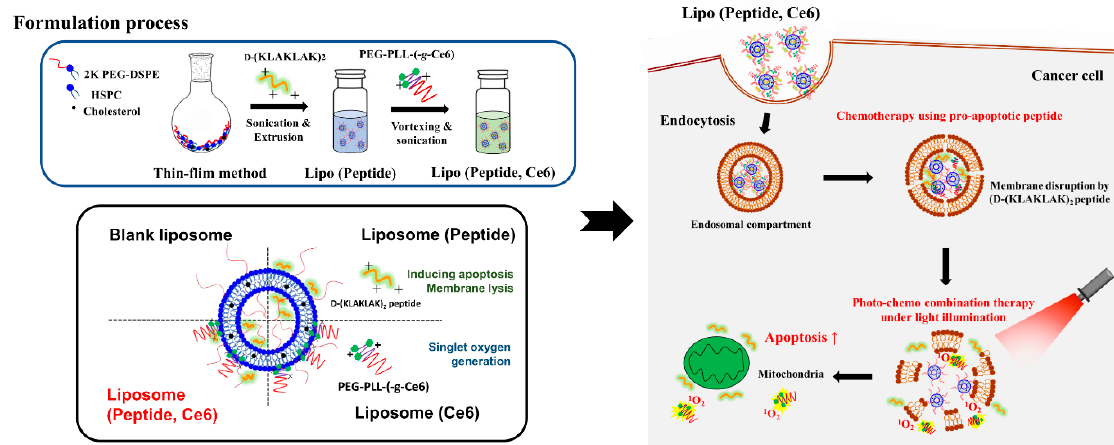
Figure 1. Schematic conceptual representation of the pro-apoptotic peptide and photosensitizer co-loaded liposomal complex system .